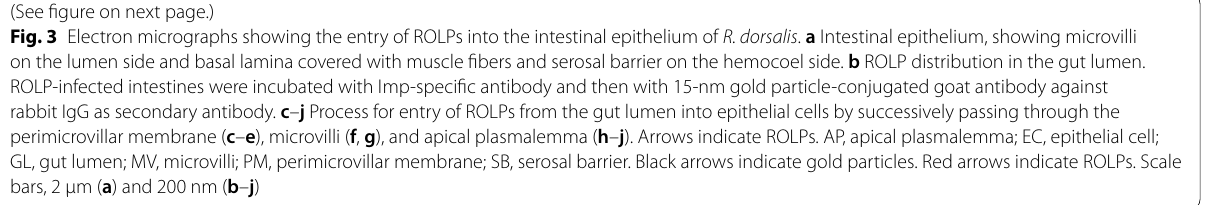
Second-instar nymphs of R. dorsalis were fed on ROLP-infected rice plants for 4 days and then transferred to healthy rice seedlings. After different periods of time following their exposure to diseased plants, the internal organs of 30 individuals were immunolabeled with ROLP antigen and counted. Amg, anterior midgut; Fc, filter chamber; He, hemolymph; Mmg, mid-midgut; Pmg, posterior midgut; Sg, salivary gland